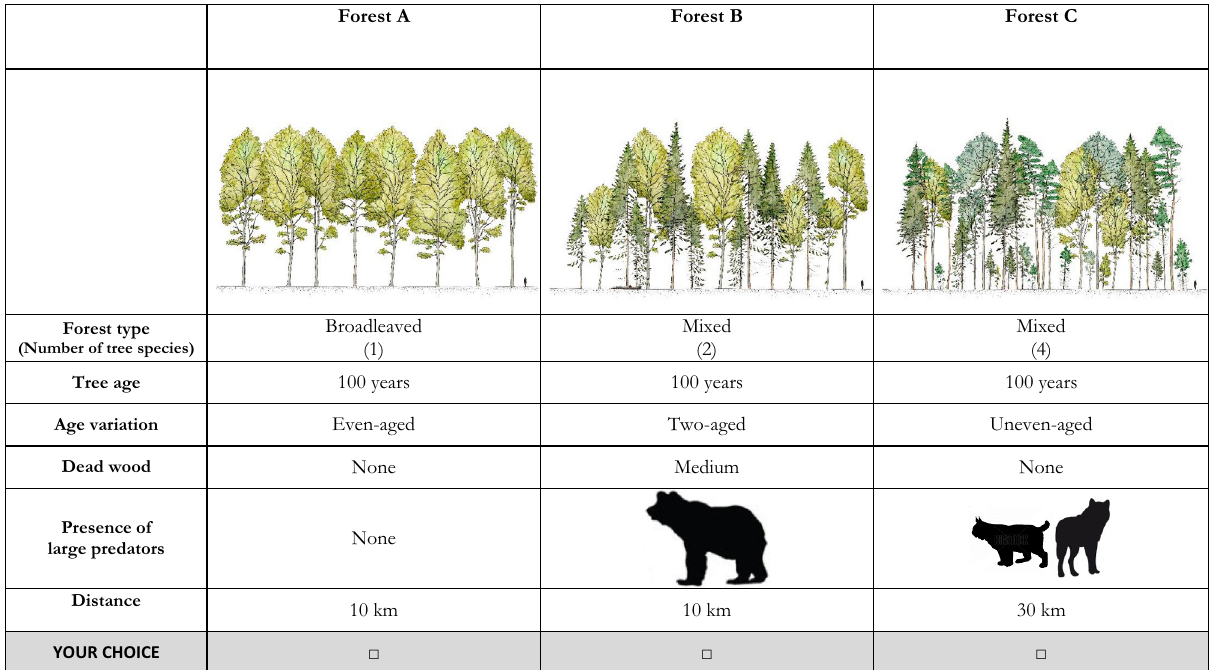
Figure 1. Example of card used in the choice experiment for assessing the preference for forest attributes in Poland and Norway, where the respondents had to select one single option.